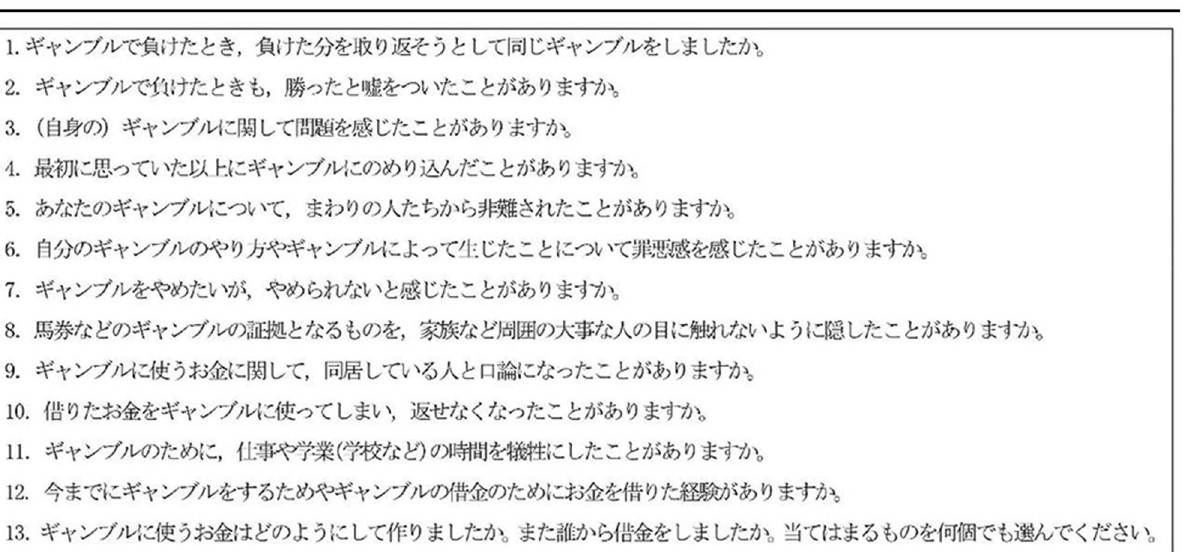
Table 2. English and modified Japanese web version of